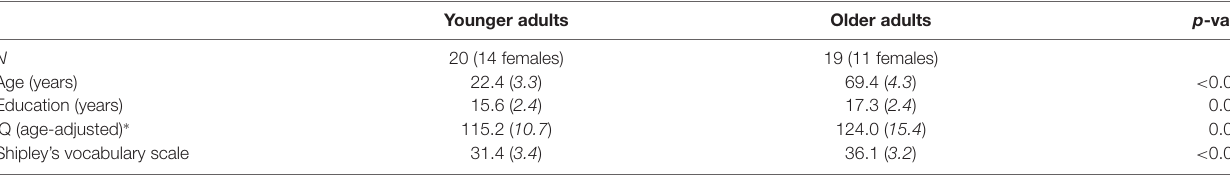
TABLE 1 | Descriptive characteristics of the sample.